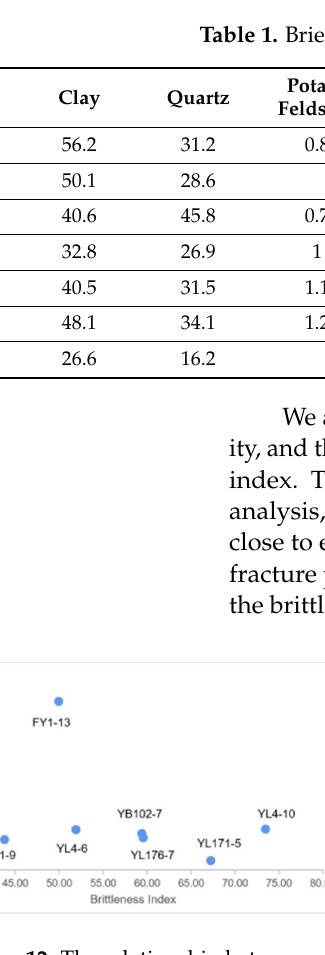
Figure 12. The relationship between sample brittleness index and microfracture porosity, contribution of microfracture and total porosity.